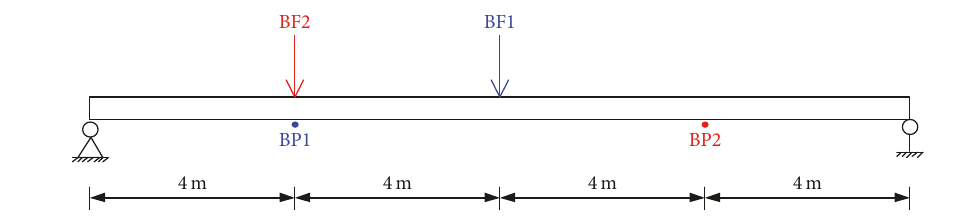
Figure 4: The simulated simply supported beam.